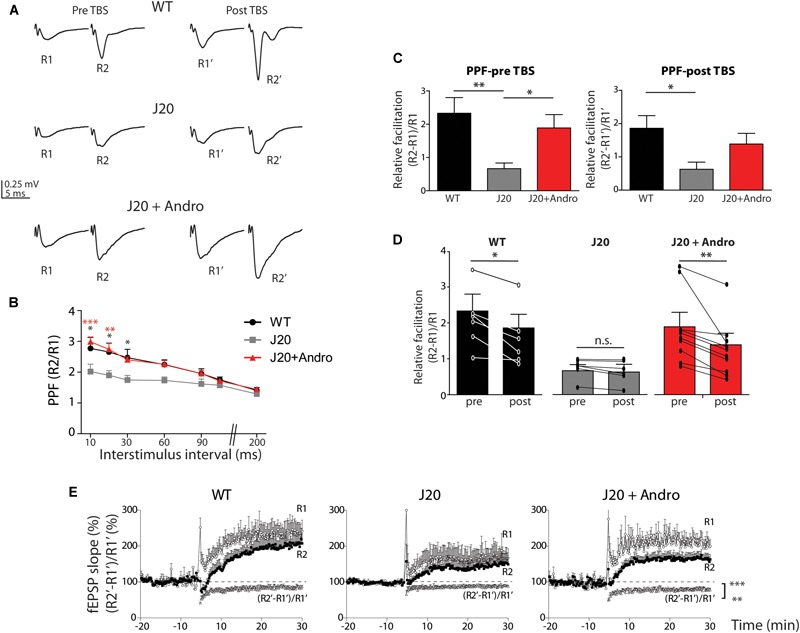
Short-term plasticity is rescued by pretreatment with ANDRO. Representative traces (A) of two evoked fEPSPs separated by 50 ms before (pre-TBS) and after LTP induction (post-TBS) are shown. The graph (B) shows the ratio of the second fEPSP slope to the first fEPSP slope (R2/R1), recorded at different interval times: 10, 20, 30, 50, 60, 80, 100, 150, and 200 ms. WT (black dots), J20 (gray squares) and J20+ANDRO (red triangles). The values are expressed as mean ± SEM [two-way repeated measures ANOVA: interaction: F(12,105) = 1.09, p > 0.05; animal group factor: F(2,105) = 19.87, p < 0.001; ISI: F(6,105) = 18.58, p < 0.001, followed by Bonferroni post hoc test: WT vs. J20 at 10, 20 and 30 ms ∗p < 0.05, beyond p = n.s.; J20 vs. J20+Andro at 10 ms ∗∗∗p < 0.001, at 20 ms ∗∗p < 0.01, beyond p = n.s.; WT vs. J20+Andro p = n.s.]. For the same stimulus point, the three curves were compared (C) show the relative facilitation during the baseline period [(R2 – R1)/R1], pre-TBS, left plot (WT: 2.3 ± 0.5; J20: 0.7 ± 0.2; J20+ANDRO: 1.9 ± 0.4; one-way ANOVA, p < 0.05, followed by Bonferroni post hoc test, ∗p < 0.05, ∗∗p < 0.01) and after LTP induction [(R2’ – R1’)/R1’], post-TBS, right plot (WT: 1.9 ± 0.4; J20+ANDRO: 1.4 ± 0.3; J20: 0.6 ± 0.2, one-way ANOVA, p < 0.05, followed by Bonferroni post hoc test, ∗p < 0.05). The average of each bar was calculated over all the points during the baseline period and the last 20 min recorded during LTP. Also shown (D) are the same data as in (C), but plotted by animal group. Comparing facilitation within each group per separated, we showed that facilitation pre-TBS is significantly different than facilitation post-TBS in WT [two-way repeated measures ANOVA: interaction: F(2,14) = 2.68, p > 0.05; pre and post TBS condition: F(1,14) = 18.33, p < 0.001; animal group factor: F(2,14) = 8.43, p < 0.01, followed by Bonferroni post hoc test, WT pre vs. post TBS ∗p < 0.05, J20 pre vs. post TBS p > 0.05, J20+Andro pre vs. post ∗∗p < 0.01]. Plot of R1’ and R2’ (%) and the percentage of attenuation [(R2’ – R1’)/R1’] (E), revealing a reduced degree of response attenuation in J20 during the first 30 min after LTP induction (one-way ANOVA, p < 0.001 followed by Bonferroni post hoc test, WT vs. J20 ∗∗∗p < 0.001, J20 vs. J20+Andro ∗∗∗p < 0.001, WT vs. J20+Andro ∗∗p < 0.01). Data represents the mean ± SEM from 16 slices of 8 (WT) mice; 18 slices of 6 (J20) mice; 18 slices of 6 (J20+Andro) mice.